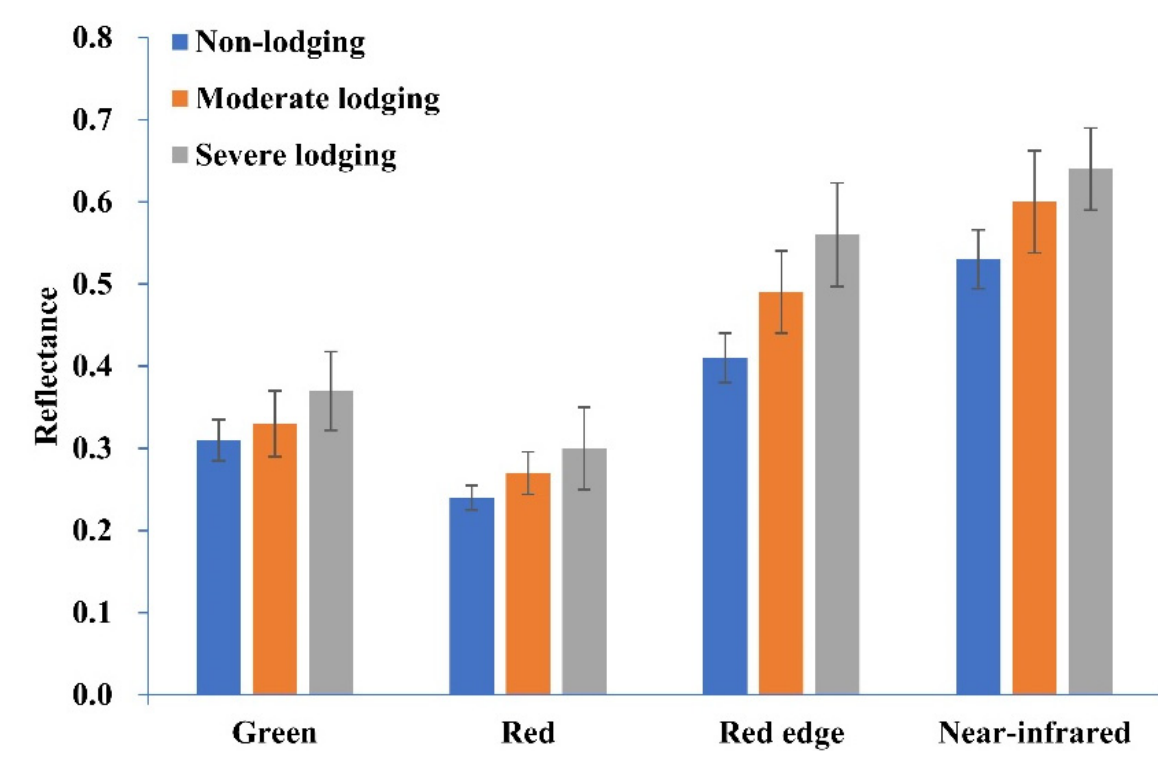
Figure 11. Spectral reflectance of four bands under different lodging extents.